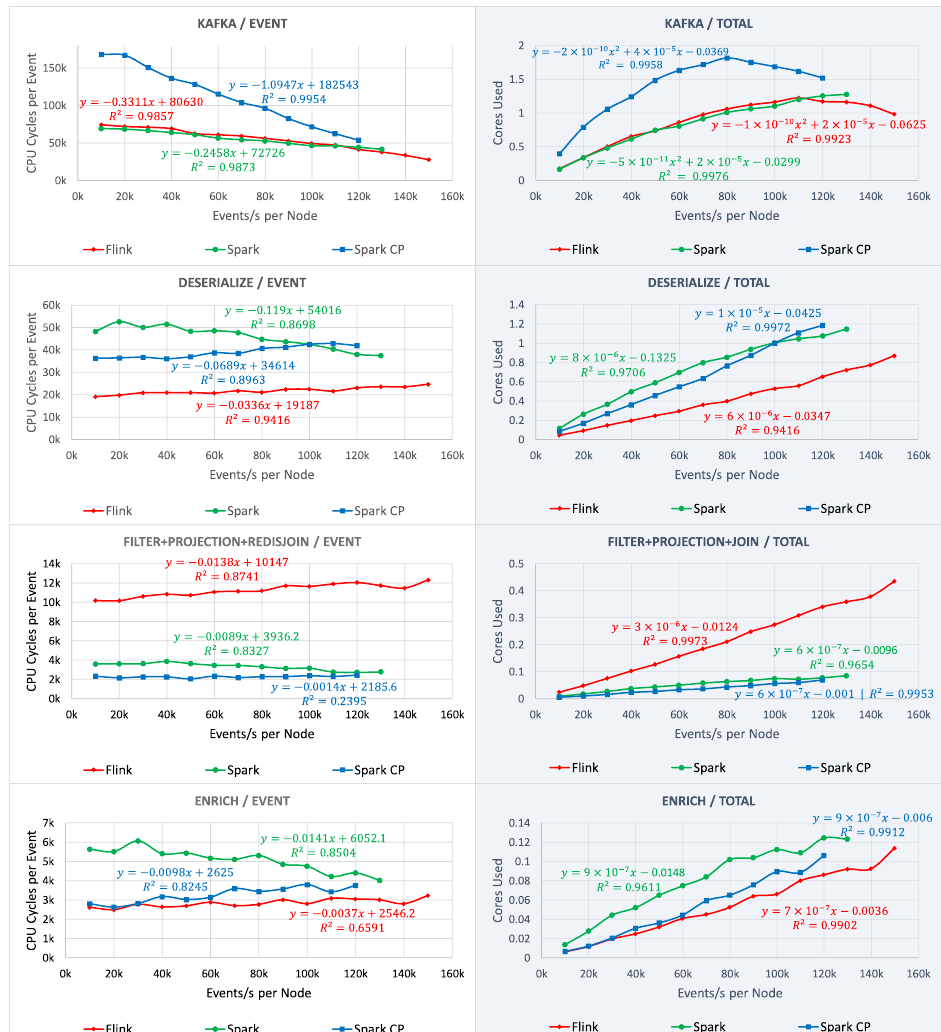
Figure 6. CPU consumption per task when scaling the